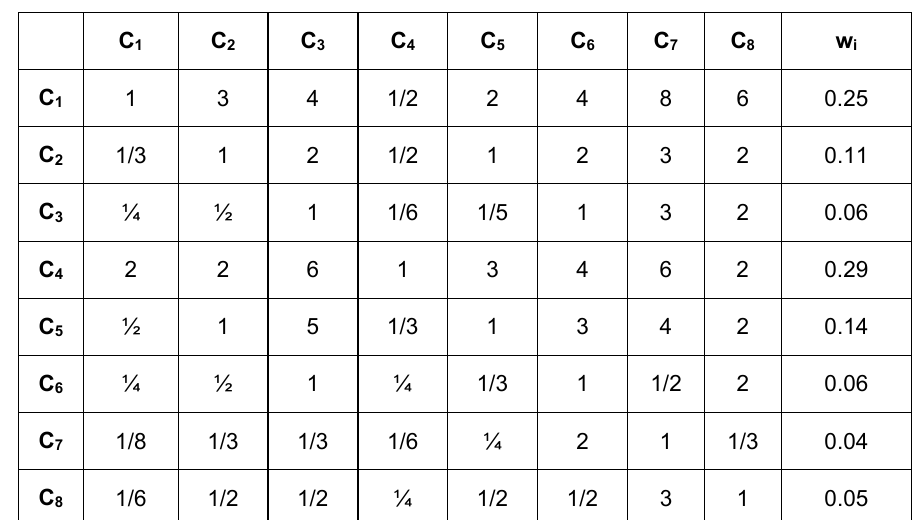
Table 4 – Comparison matrix and the weights of criteria Таблица 4 – Сопоставительная матрица и весовой